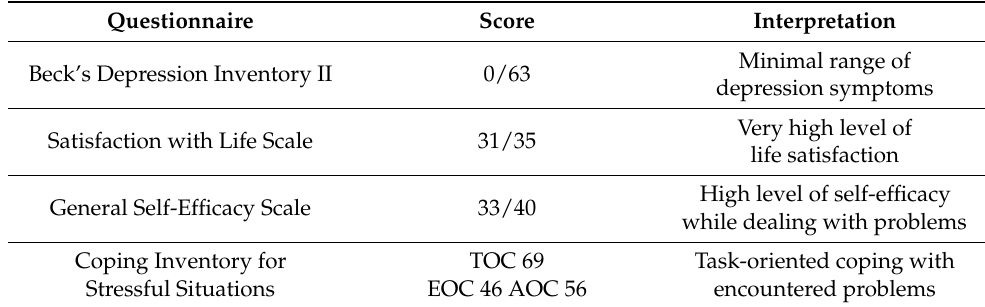
Table 2. Results of mental and psychological